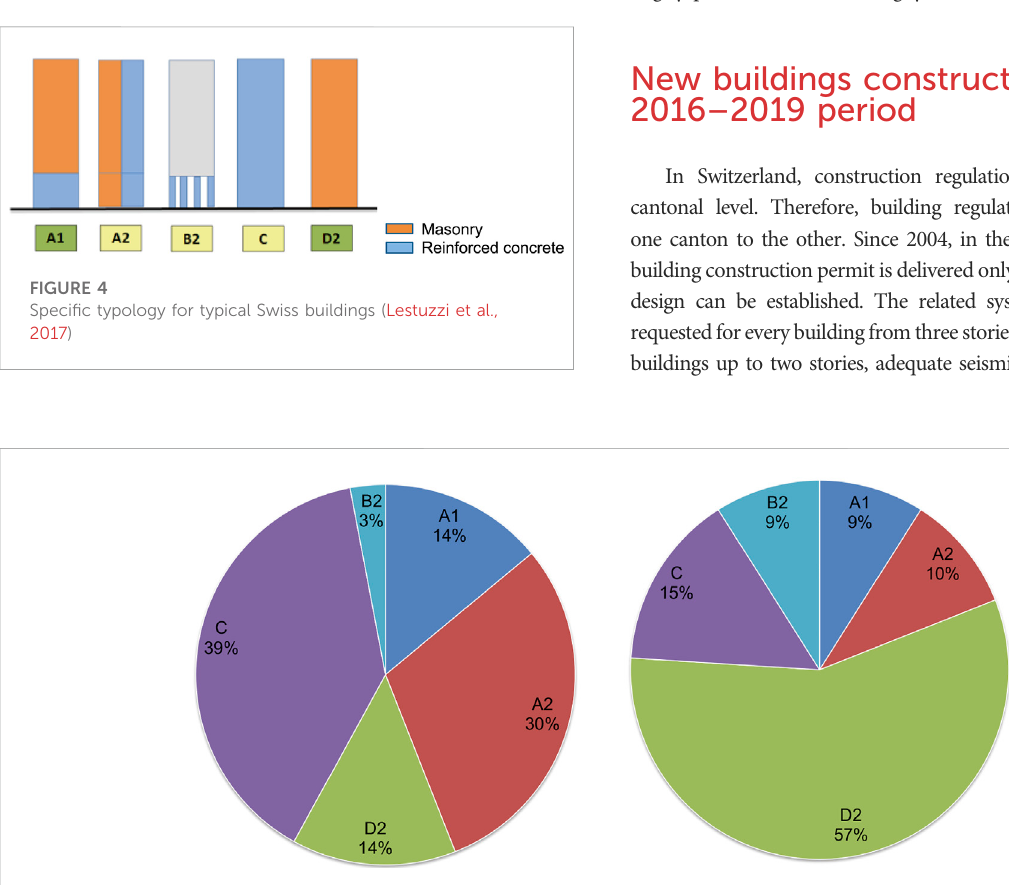
FIGURE 5 Distributions for the 845 buildings of Sion (left) and the 391 buildings of Martigny (right) in the speci fi c Swiss typology (Diana et al.,